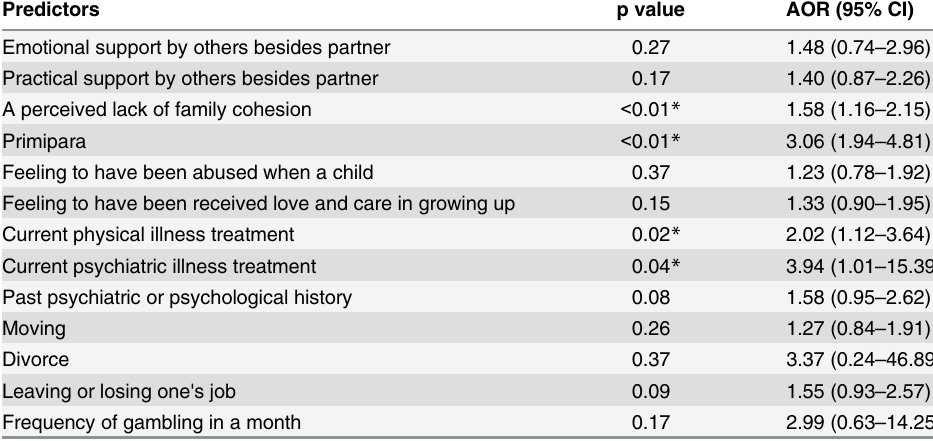
Table 4. The results of the of multivariate analysis of predictive factors at 20 weeks gestation for post- partum depression except for the Edinburgh Postpartum Depression Scale. Predictors p value AOR (95% CI) Emotional support by others besides